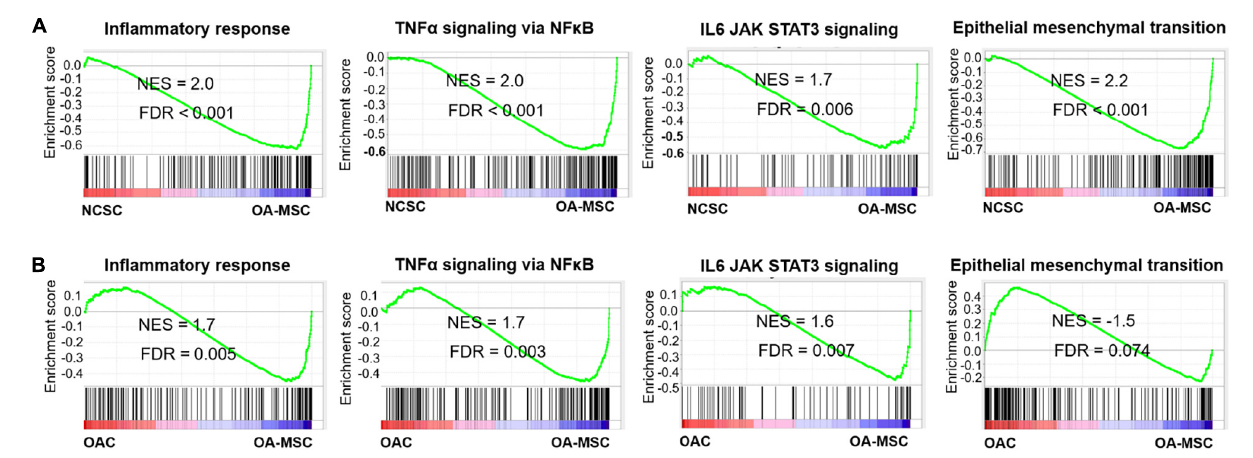
FIGURE 3 | Gene Set Enrichment Analysis of key pathways activated during OA-MSC transition. (A) GSEA analysis indicated that inflammatory response (NES = 2.0, FDR < 0.001), TNF α signaling via NF κ B (NES = 2.0, FDR < 0.001), IL6-JAK-STAT3 signaling (NES = 1.7, FDR = 0.006), and epithelial mesenchymal transition (EMT) (NES = 2.2, FDR < 0.001) were activated during the NCSC to OA-MSC transition. RNAseq data of human OA-MSC2 and NCSC3 were utilized for analysis. (B) GSEA analysis indicated that inflammatory response (NES = 1.7, FDR = 0.003), TNF α signaling via NF κ B (NES = 1.7, FDR = 0.003), and IL6-JAK-STAT3 signaling (NES = 1.6, FDR = 0.007) were activated during the OAC to OA-MSC transition. RNAseq data of human OAC and OA-MSC2 were utilized for analysis. NES > 1.5 and FDR < 0.05 were considered